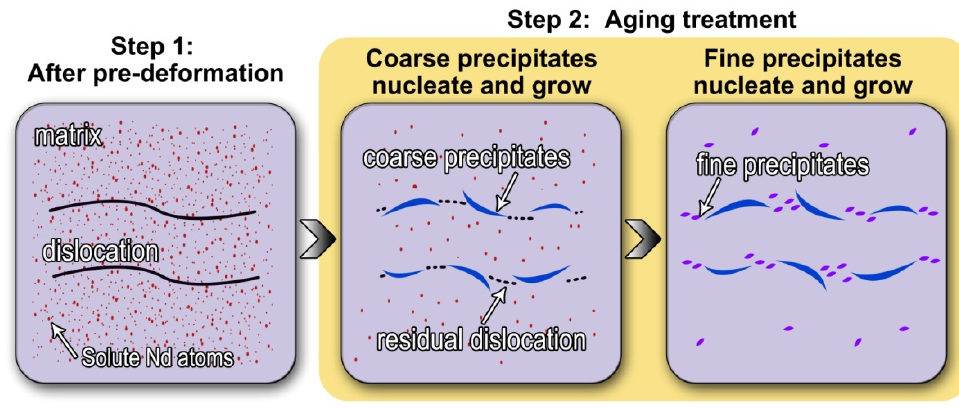
Figure 9. Schematic diagrams of precipitates evolution during aging treatment.